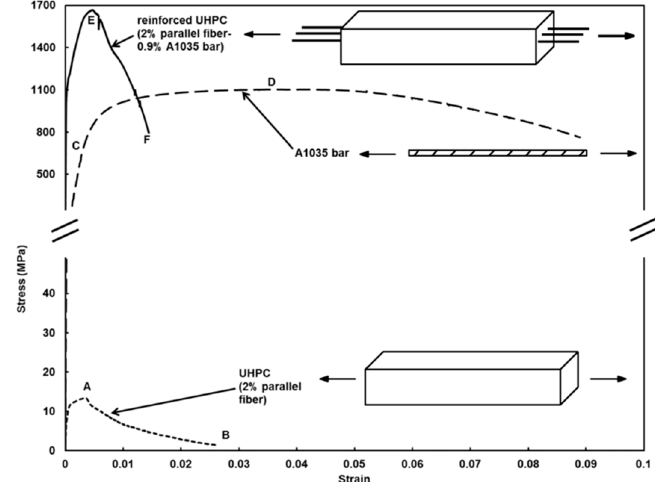
Figure 2. Comparison of stress versus strain curves of UHPC, reinforced UHPC, and reinforcement steel.